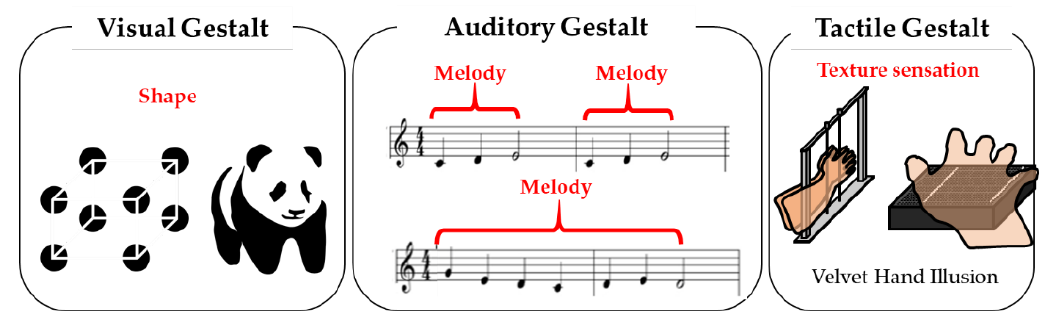
Figure 3. Gestalt features in each modality. The shape from parietal parts is recognized in the visual Gestalt. A melody is recognized in the auditory Gestalt when the frequencies close to each other on the time axis are grouped together. A smooth sensation is invoked in the tactile Gestalt.